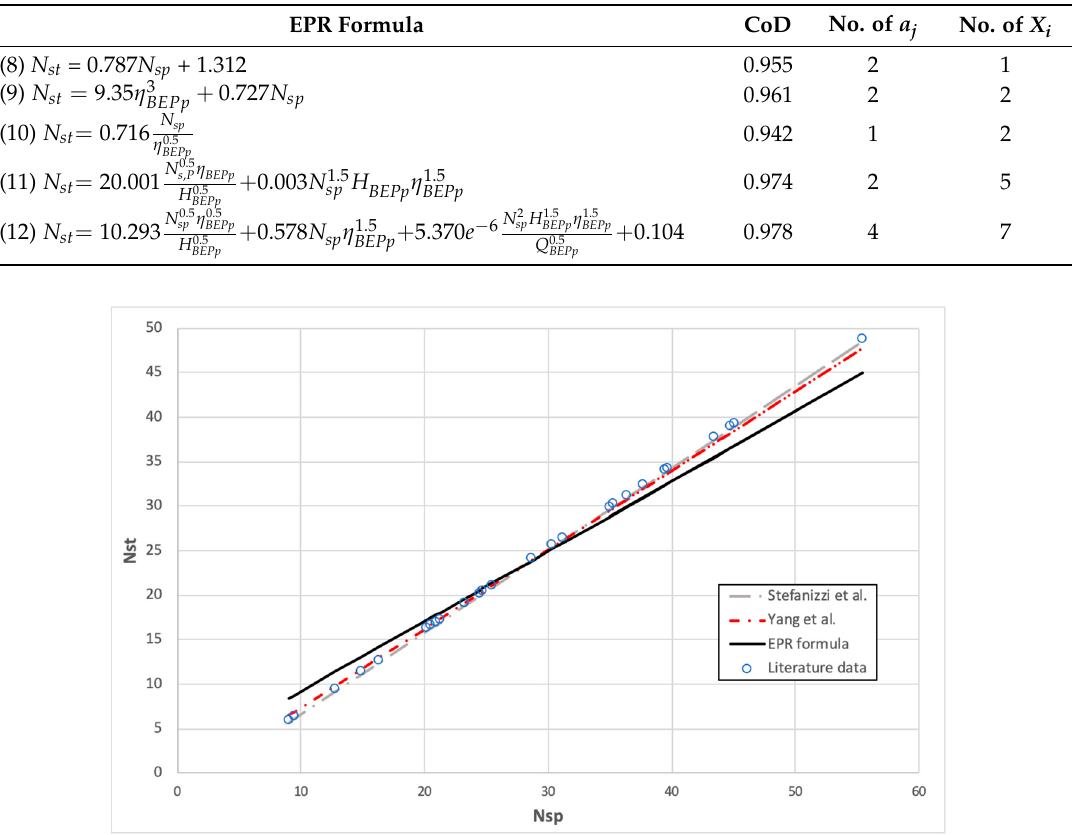
Table 11. Models returned by EPR-MOGA for Q BEPt.